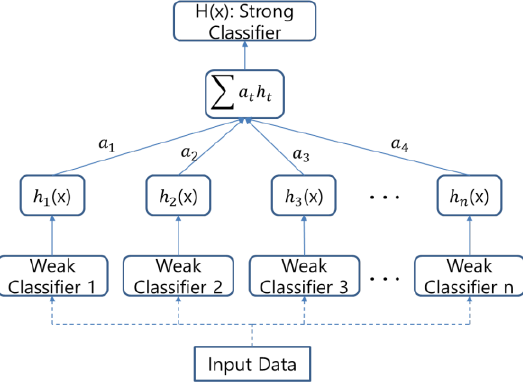
Figure 8. Vehicle detector training.